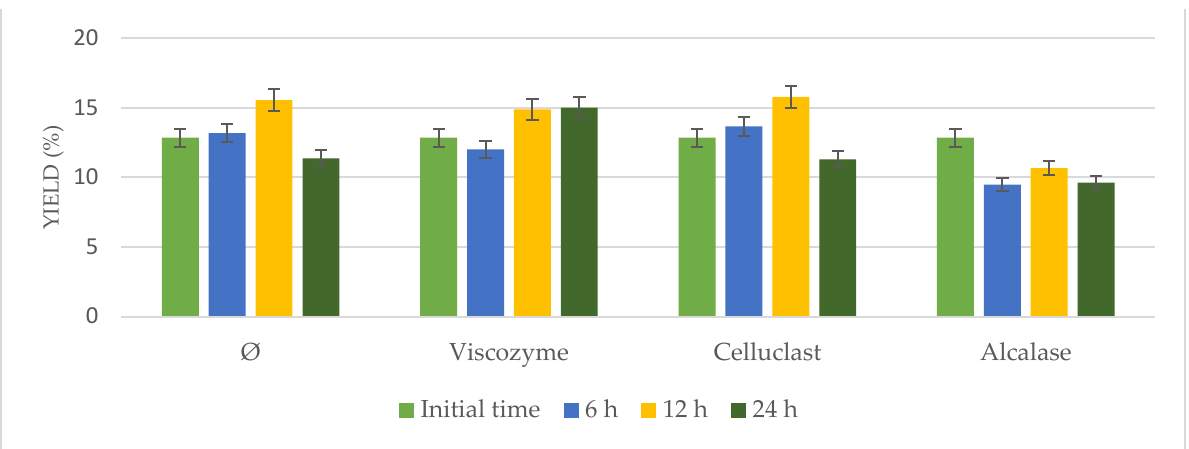
Figure 1. Oil yield of pretreated N.gaditana biomass after enzymatic incubation at 55 °C at different times (6, 12, and 24 h) compared to not pretreated biomass (Ø ) under the same conditions.